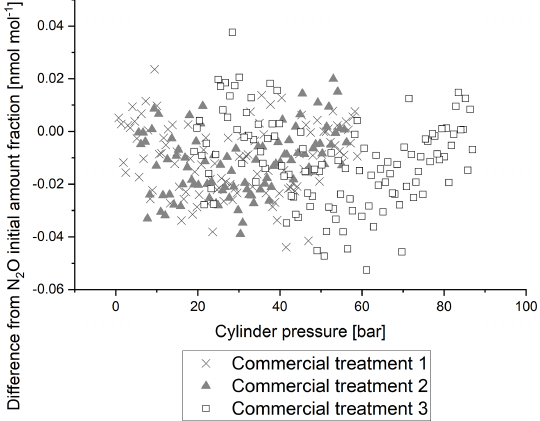
Figure 6. Difference from initial N 2 O amount fraction with reduc- ing cylinder pressure for three 325nmolmol − 1 N 2 O-in-synthetic- air reference materials produced in 10L cylinders with three differ- ent commercially available cylinder passivation